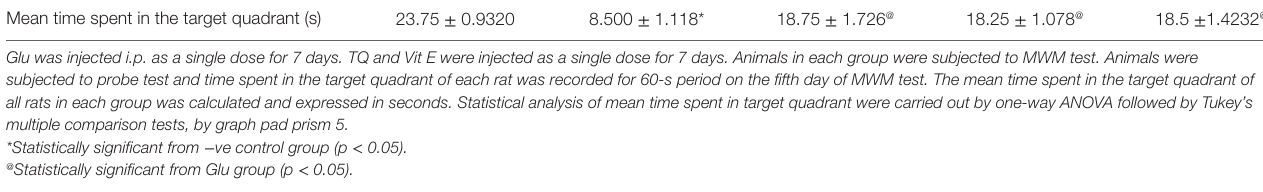
TaBle 3 | Effect of Glu, Vit E/Glu, TQ 2.5/Glu, and TQ 10/Glu on the probe test in Morris water maze (MWM). groups − ve control